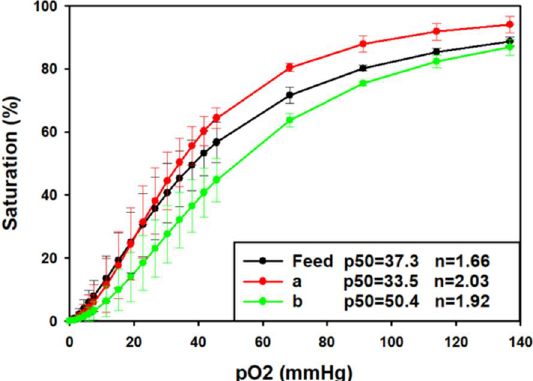
Figure 8. Oxygenation saturation curves for a single pass of SCD blood through the magnetic sorter. The oxygen partial pressure at 50% saturation (p50) and Hill coefficient (n) for cooperative oxygen binding to Hb are included in the plot. The enriched (green) curve shows a much lower saturation than the feed (black), particularly at low pO 2 . This indicates the presence of irreversibly polymerized and deoxygenated RBCs containing HbS. The CTV scatter plots only show small shifts in mobility and sedimentation but reflect the high and low extremes of pO 2 . Characterizing the outlet fractions throughout the intermediate saturations reveal that some RBCs in heterogenous apheresis waste have very low oxygen uptake (and, therefore, quite paramagnetic) at intermediate oxygen